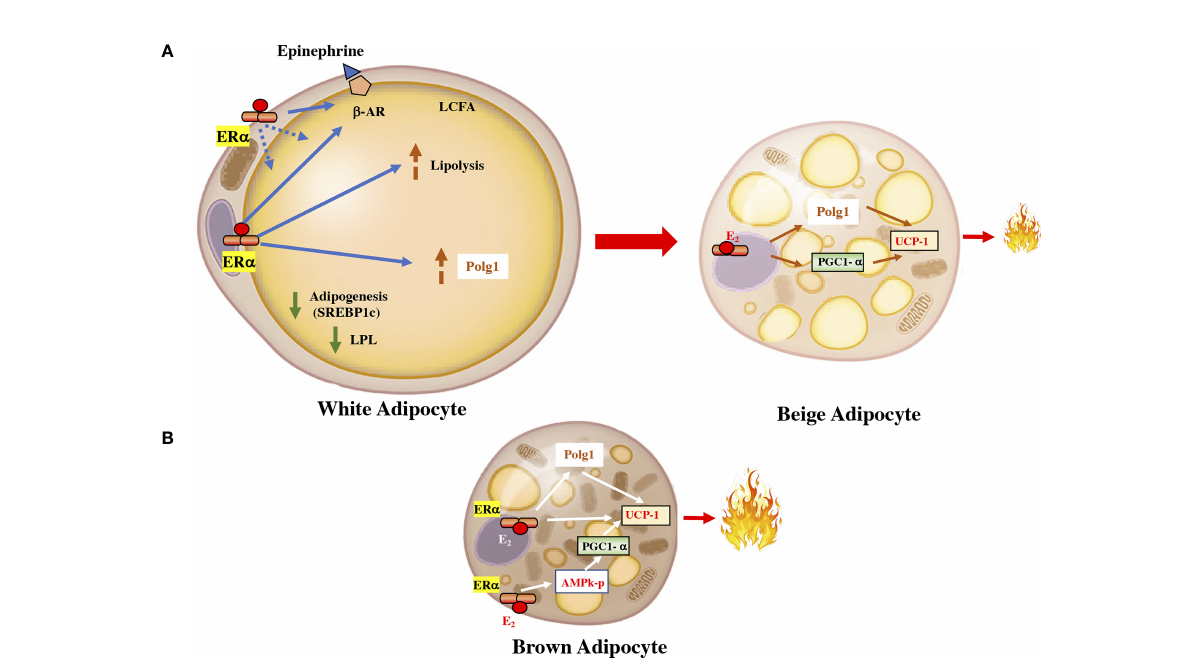
FIGURE 2 Estrogen in the fat cell. (A) In white adipocytes, the activation of the ER a receptor by estrogen downregulates lipoprotein lipase and increases the activity of the b -adrenergic receptor. It also increases the activity of Polg1 and increases mitochondrial activity. These effects can upsurge the transdifferentiation of white adipocytes into beige adipocytes, which are more energetically active. (B) In brown adipocyte cells, ER a can increase the expression of UCP1 by increasing the PGC1 a coactivator through AMPK and by a direct effect on the receptor coactivator. UCP1, uncoupling protein 1; PGC1 a , peroxisome proliferator-activated receptor gamma coactivator 1 alpha; ER a , estrogen receptor alpha; AMPK, AMP-activated protein kinase. LPL, lipoprotein lipase; b -AR, beta-adrenergic receptor; Polg1, mitochondrial DNA polymerase gamma; SREBP1c, sterol regulatory element-binding transcription factor